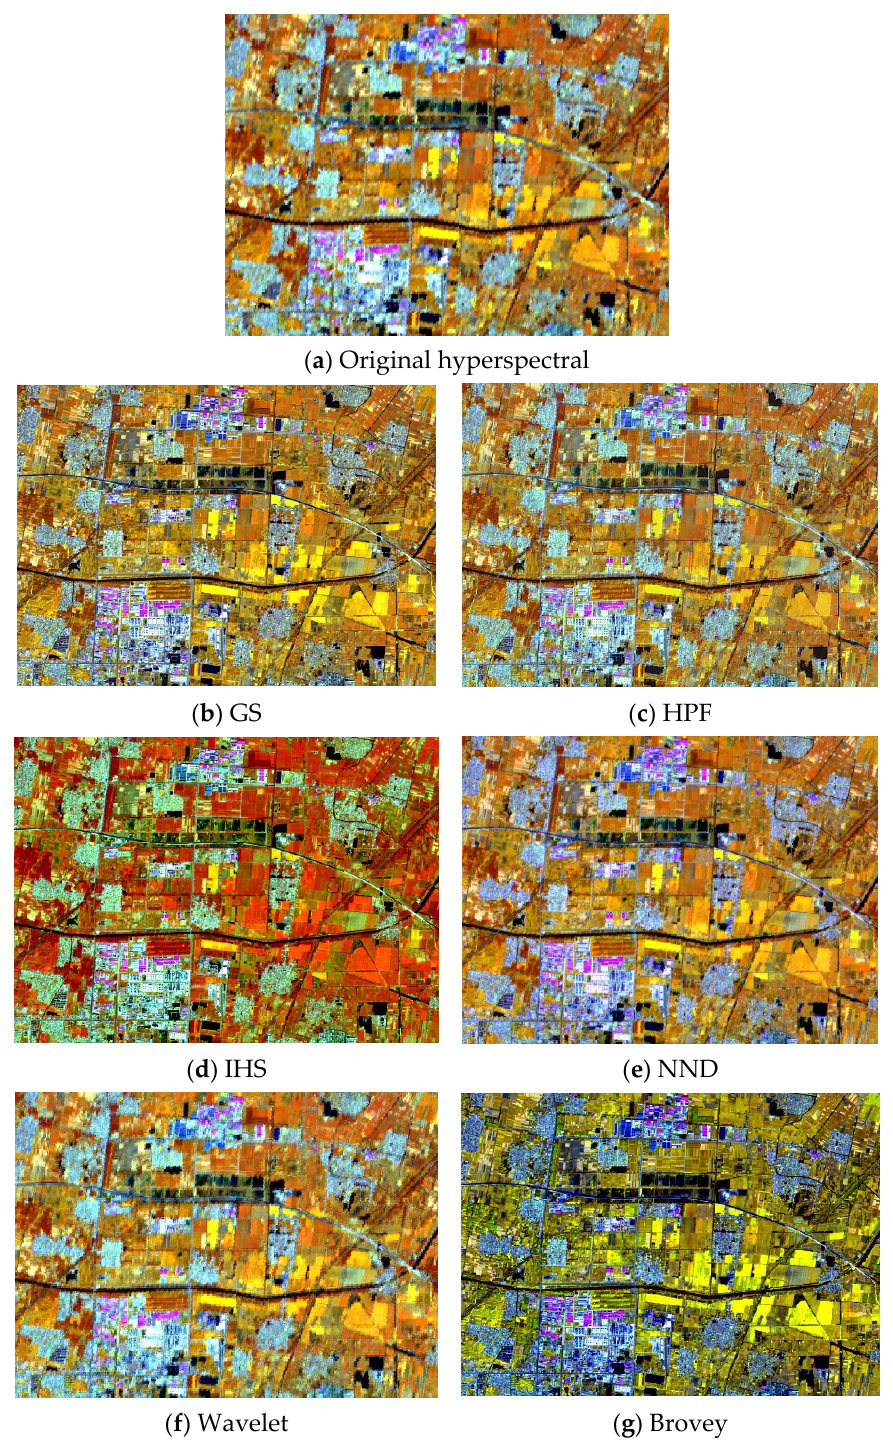
Figure 6. The details of farmland and artificial buildings. ( a ) ZY-1 02D original hyperspectral